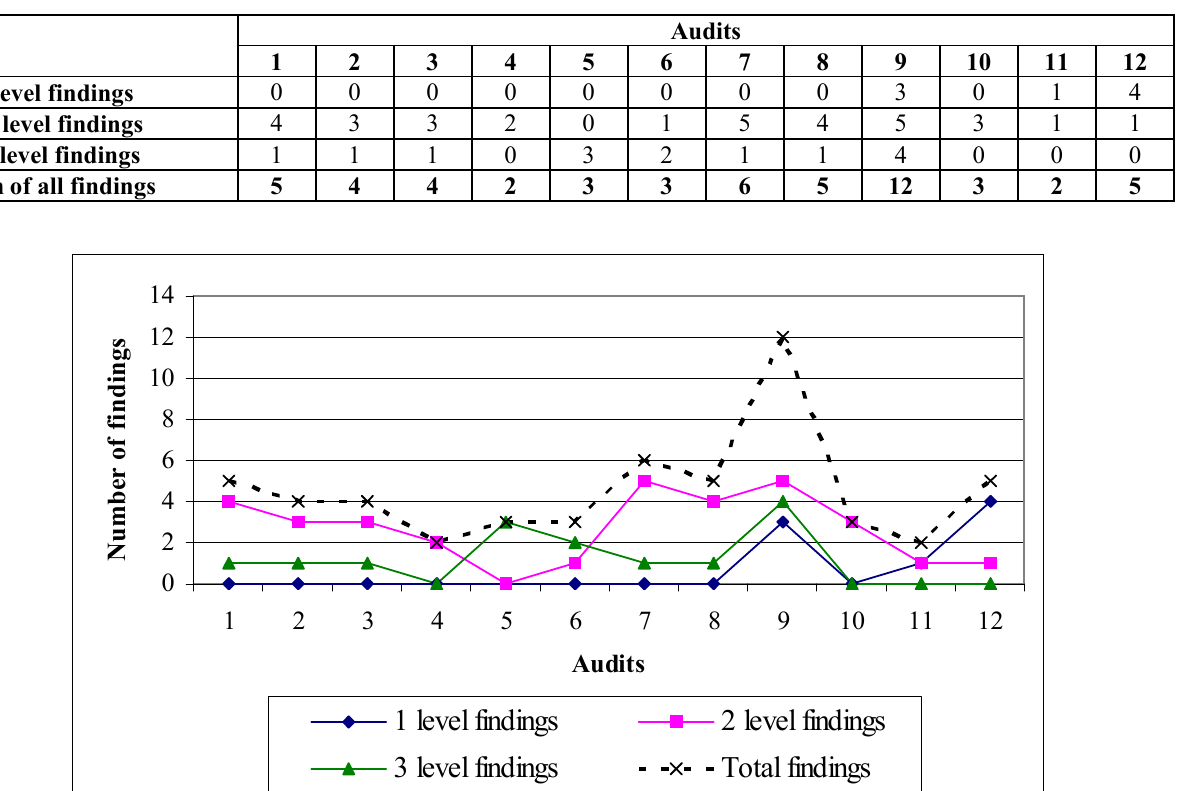
Fig 4. The chart of organization’s YYY department internal audits